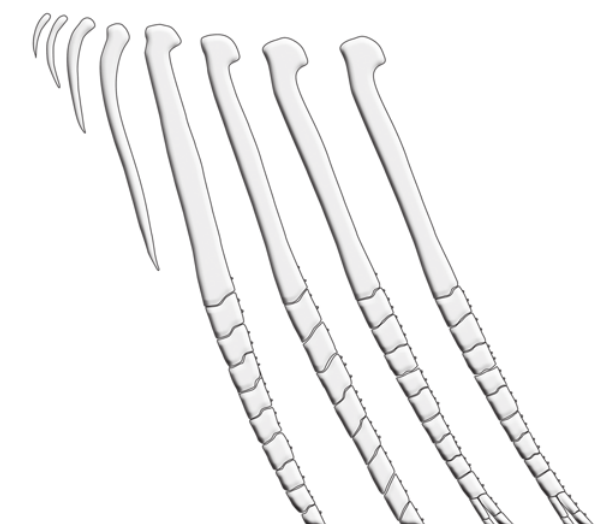
Fig. 12. Hooks on anterior anal-fin rays of Charax gibbosus , male, MZUSP 10675, 64 mm SL.